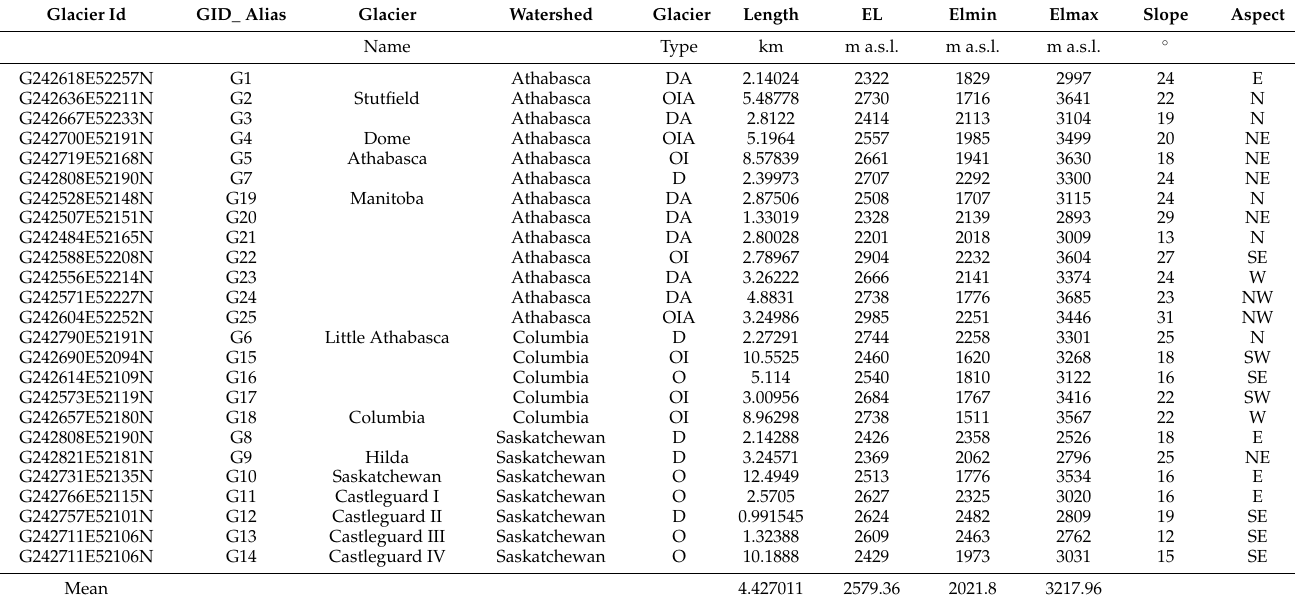
Table 1. Characteristics and spatial extents of glaciers in the Columbia Icefield. Glacier